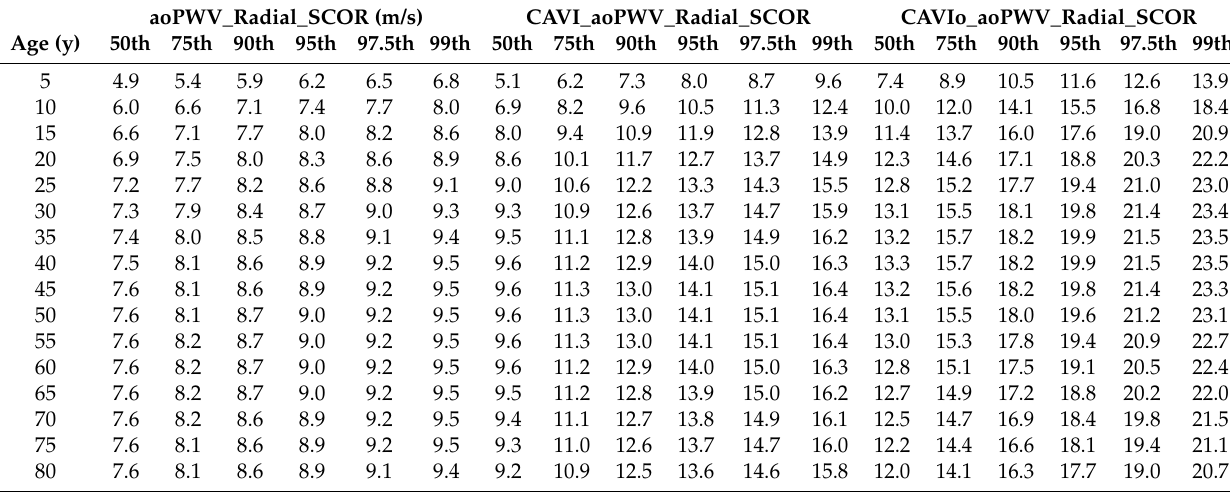
Table 10. aoPWV_Radial_SCOR levels and related parameters (CAVI and CAVIo) reference intervals: